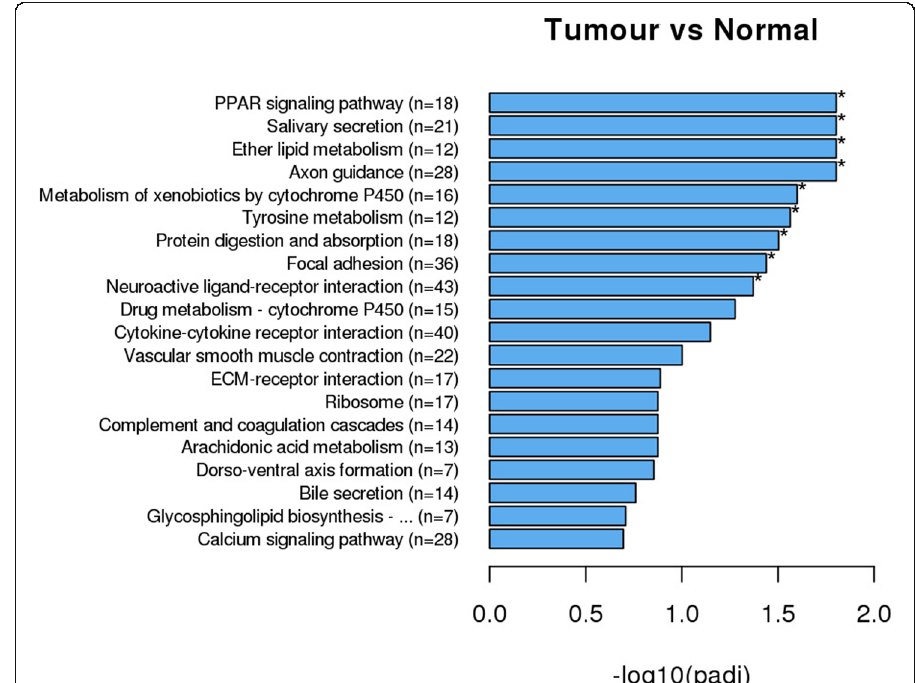
Fig. 5 KEGG pathways significantly enriched with downregulated genes. n = the number of DEGs enriched in the pathway. X-axis represents the q value. * p <